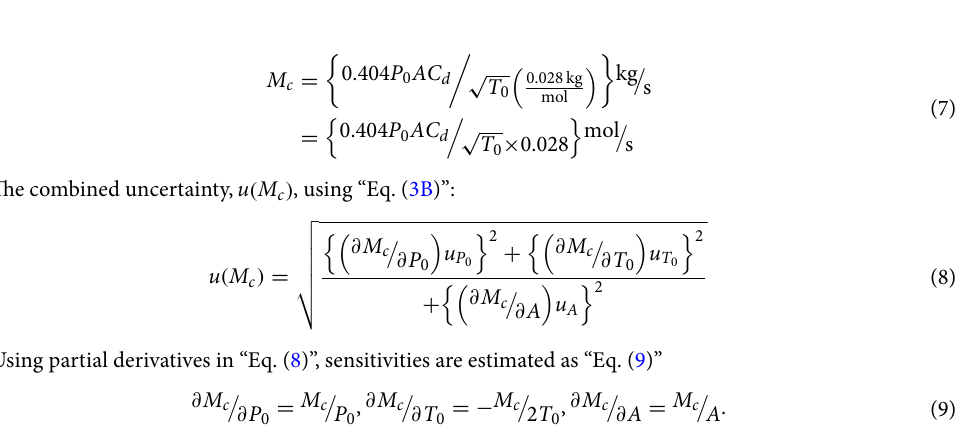
The combined uncertainty, u ( M c ) , using “Eq. (3B)”: